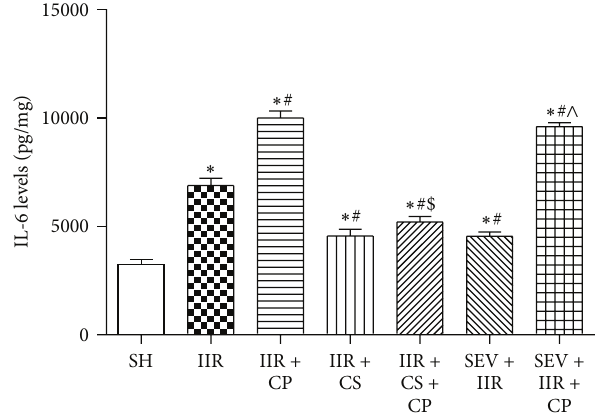
Figure 5: Levels of IL-6 in intestine after IIR injury. SH group (Sham-operated group), IIR group (75 min intestinal ischemia and 2 h reperfusion), IIR + CP group (IIR group + Compound 48/80 1mg/kg), IIR + CS group (50 mg/kg cromolyn sodium treated IIR group), IIR + CS + CP group (50 mg/kg cromolyn sodium treated IIR group + Compound 48/80 1mg/kg), SEV + IIR group (2.3% sevoflurane pretreated IIR group), and SEV + IIR + CP group (2.3% sevoflurane pretreated IIR group + Compound 48/80 1 mg/kg). Bar graph quantified IL-6 levels in intestinal mucosa. Results are expressed as Mean ± SEM. 𝑛 = 6 per group. ∗ 𝑃 < 0.05 versus SH group, # 𝑃 < 0.05 versus IIR group, $ 𝑃 < 0.05 versus IIR + CP group, & 𝑃 < 0.05 versus IIR + CS group, and ∧ 𝑃 < 0.05 versus SEV + IIR